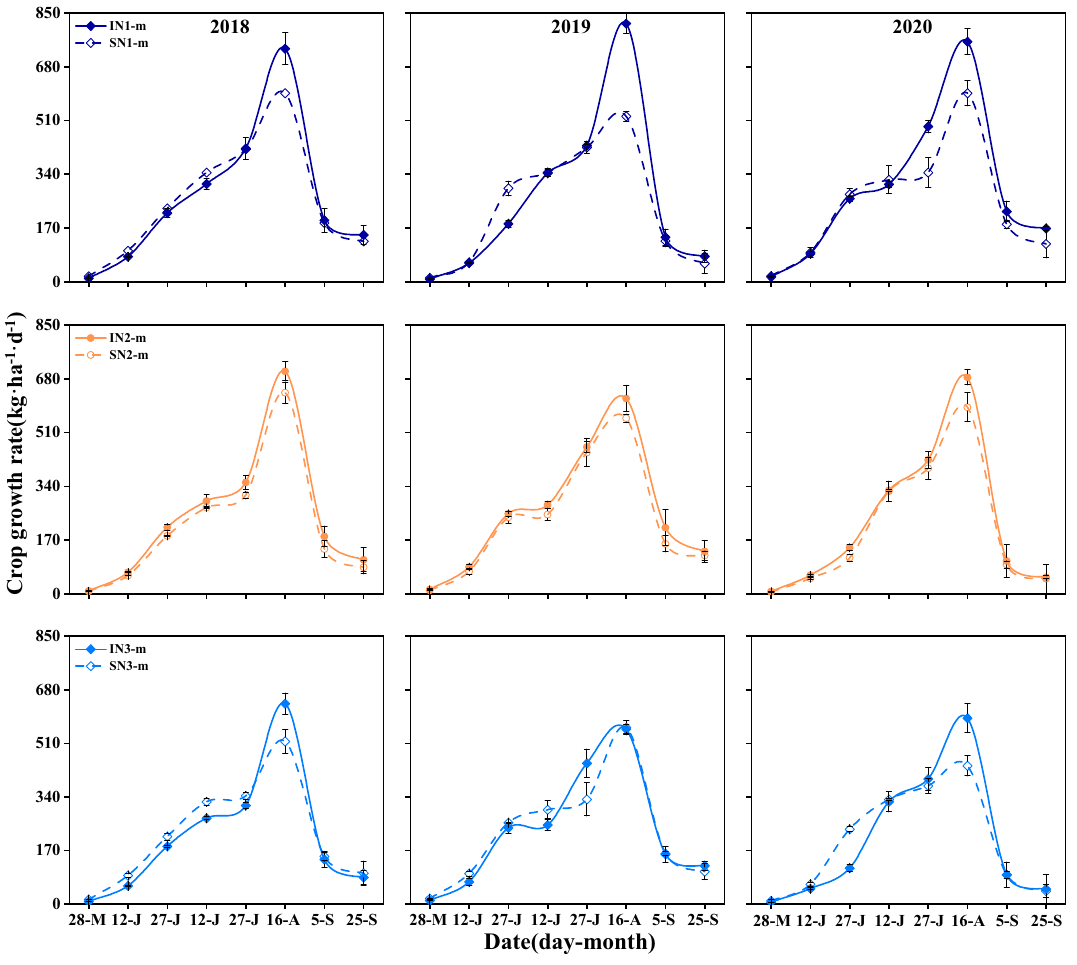
Figure 3. Crop growth rate of maize in sole and intercropping systems in 2018–2020 with different cropping system and N management system. I, intercropping, S, sole cropping. For intercropping system, N 1 , N 2 , and N 3 represent N-fertilizer applied at 51, 72, and 93 kg N ha −1 as first top-dressing plus 63, 42, and 21 kg N ha −1 at third top-dressing, respectively. For sole maize, N 1 , N 2 and N 3 represent N-fertilizer applied at 36, 72, and 108 kg N ha −1 as first top-dressing plus 108, 72, and 36 kg N ha −1 at third top-dressing, respectively. Plant sampling time is 15 day intervals before wheat harvest and 20 day intervals after wheat harvest. Error bars indicates standard error of the means ( n =